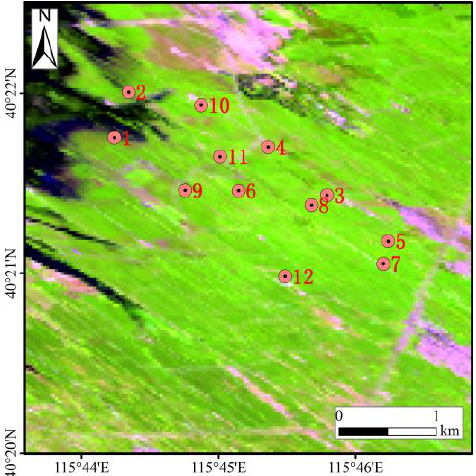
Figure 1. Map of the study area. The background image is the false color composition with bands 6-5-4 of the Landsat 8 Operational Land Imager (OLI) image acquired on August 23, 2013. The points and numbers indicate the locations of the twelve below nodes in the LAINet observation system deployed in the study area.